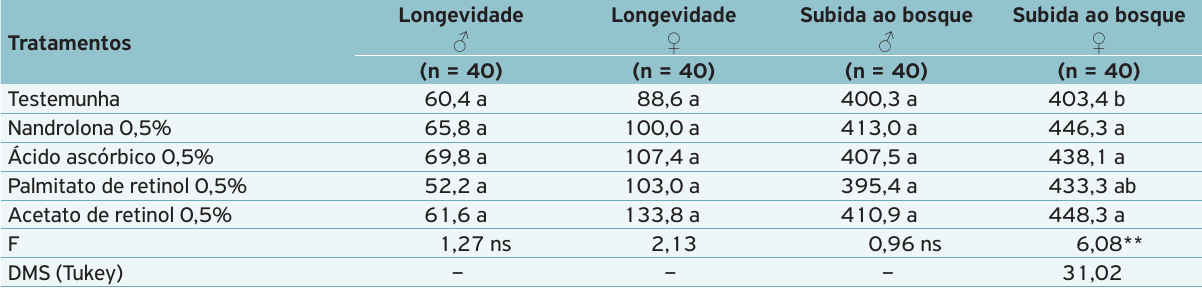
Tabela 5. Longevidade (horas) de machos e fêmeas e duração do período de subida ao bosque de machos e fêmeas (horas) de Bombyx mori alimentados com folhas de amoreira contendo diferentes aditivos aplicados por imersão.